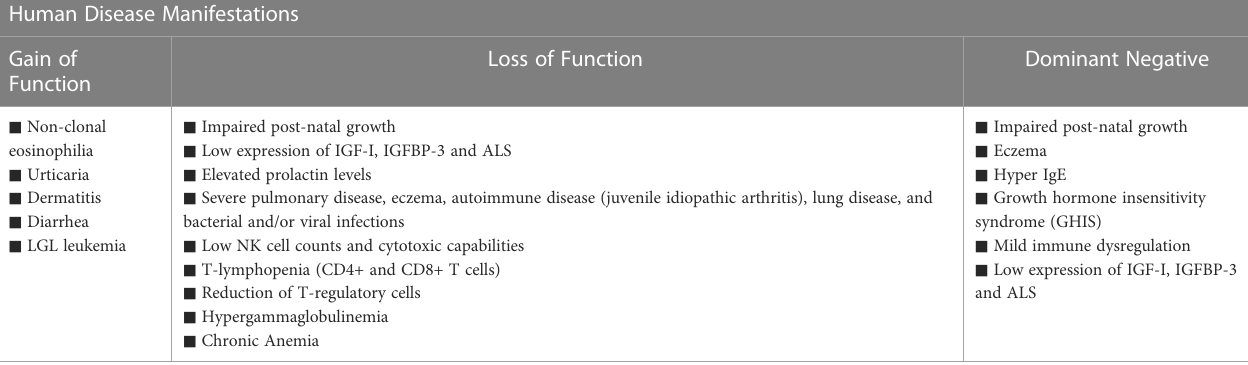
TABLE 1 Human Disease Manifestations. Human Disease Manifestations Gain of